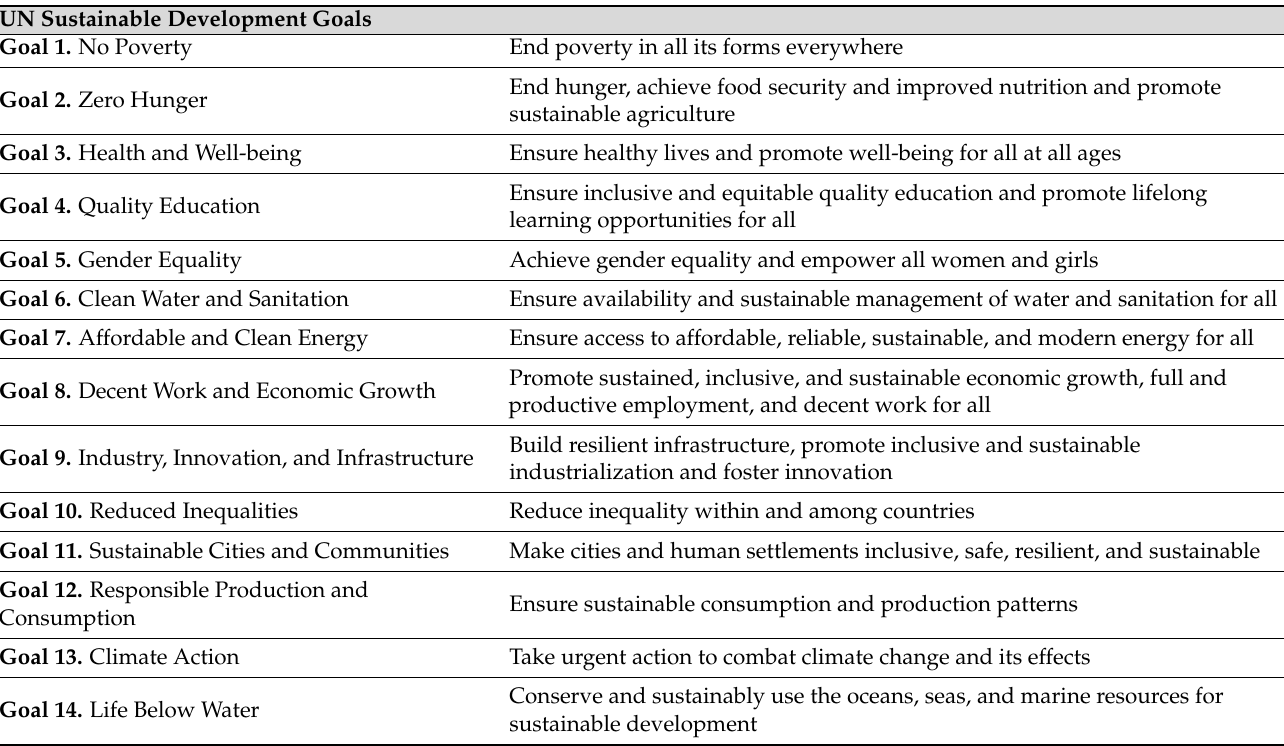
Table 1. UN Sustainable Development